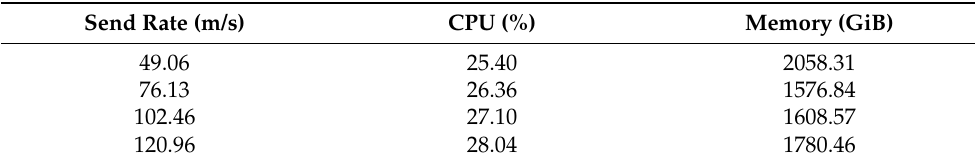
Table 3. CPU and memory usage for the SETS framework without blockchain (baseline).